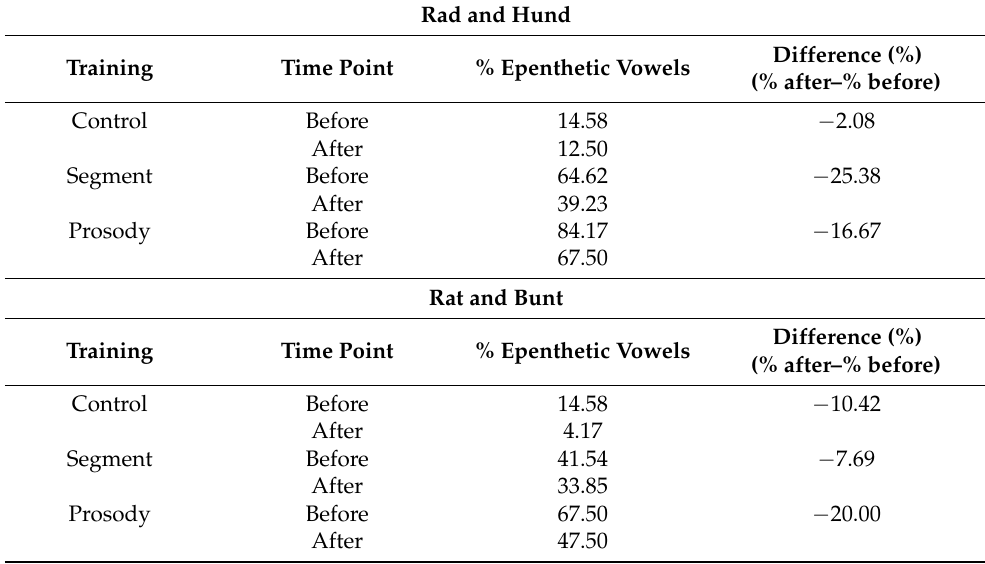
Table 4. Epenthetic vowel results.